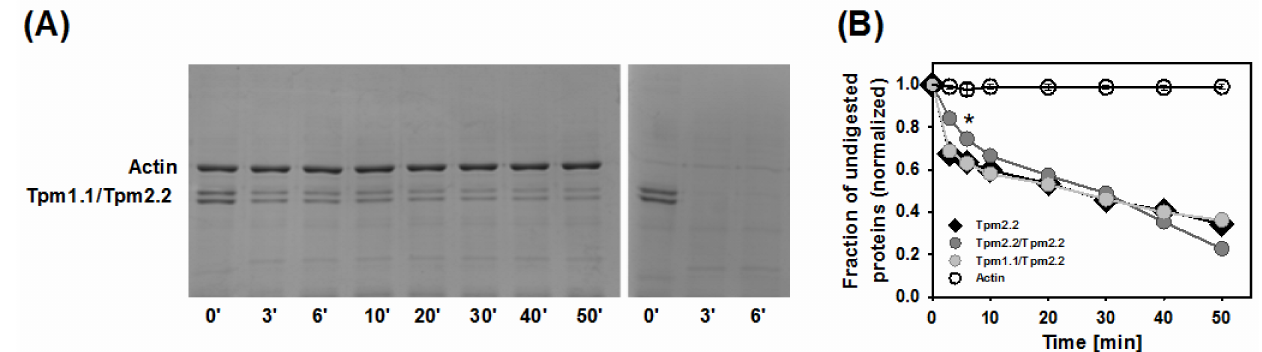
Figure 4. Trypsin digestion of wild type Tpm2.2 homo- and heterodimers. ( A ) Representative polyacrylamide gels showing the digestion time course of heterodimer Tpm1.1/Tpm2.2 in the presence (left panel) and absence (right panel) of F-actin. ( B ) Averaged fraction of undigested F-actin (open circles) in the presence of tropomyosin variants. Fraction of undigested wild type tropomyosin variants bound to F-actin: Tpm2.2 homodimer (black diamonds), crosslinked Tpm2.2/Tpm2.2 (dark grey circles), crosslinked Tpm1.1/Tpm2.2 heterodimer (light grey circles). The points represent the mean ± SE ( n = 3–5). Statistical analysis was carried out by one-way ANOVA for 6 min of digestion (* p ≤ 0.05). Conditions as described in Materials and Methods.